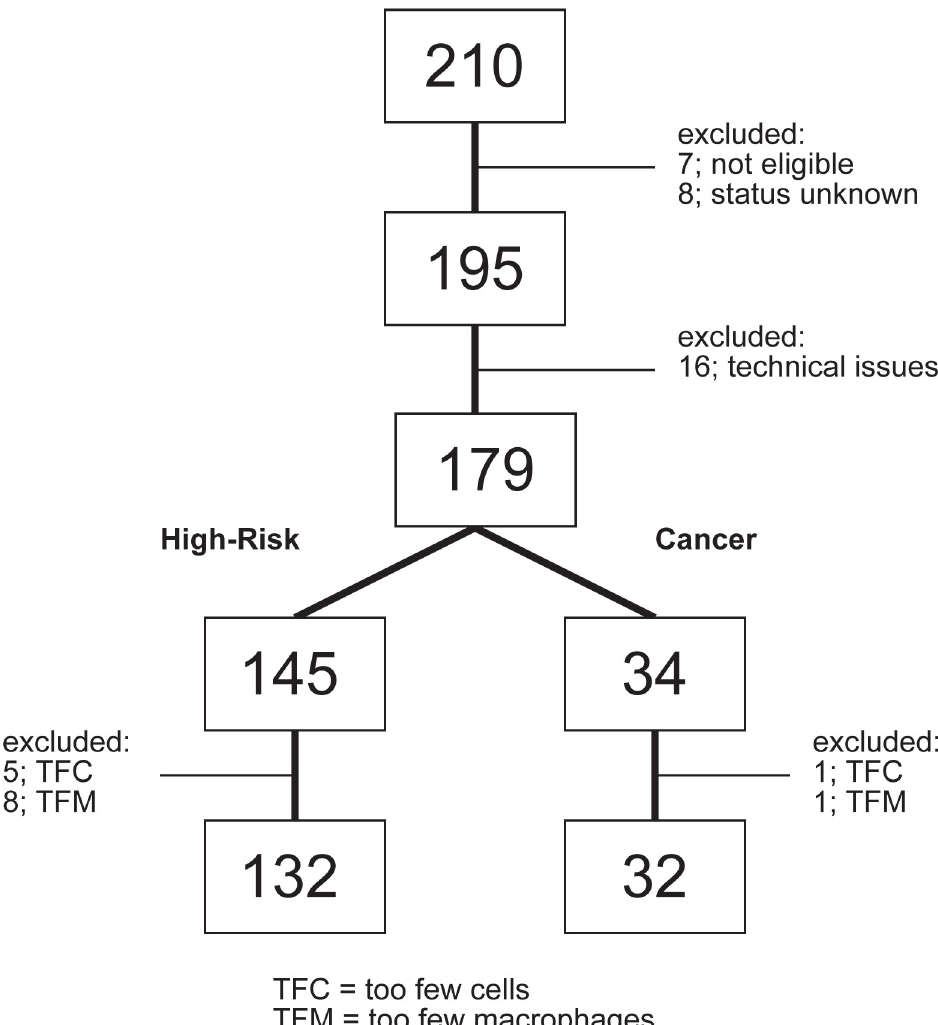
Fig 1. Scheme of patient sample utilization. Two hundred and ten sputum samples were collected. Thirty-one samples were initially excluded, leaving 179 samples for flow cytometric analysis. An additional 15 samples were omitted from the final analysis because of either too few cells in general (which does not amount to a reliable profile) or too few macrophages (which casts doubt to the lung origin of the sample). Ultimately 132 high-risk and 32 cancer samples were fully